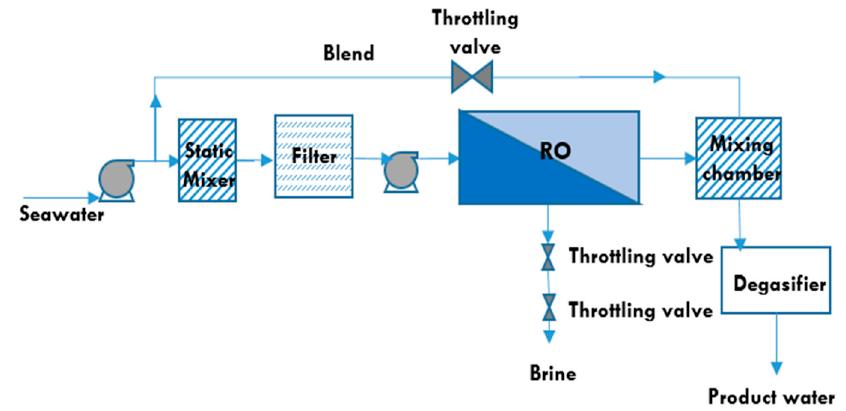
Figure 5. Flow schematic of a reverse osmosis unit receiving brackish water.